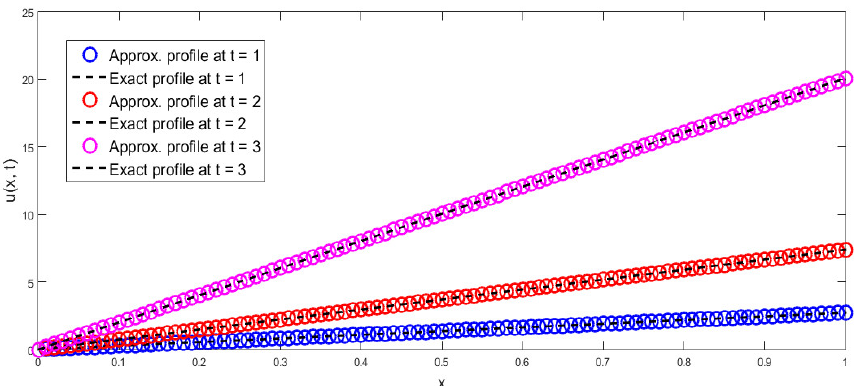
Figure 3. Comparison of approx. and exact profiles at t = 1, 2, 3 regarding Example 3.